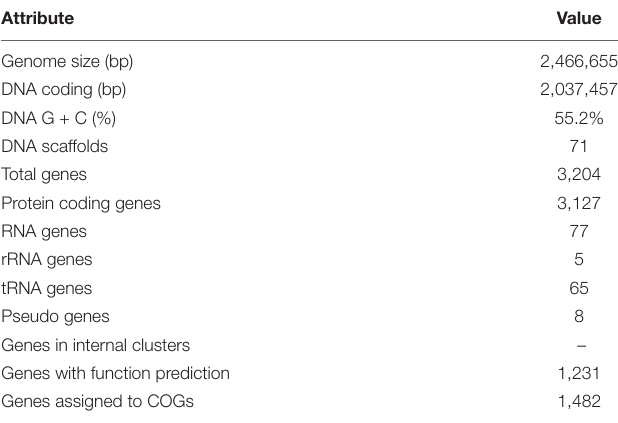
TABLE 2 | Genome statistics of “ Ca . Methylacidithermus pantelleriae” PQ17.